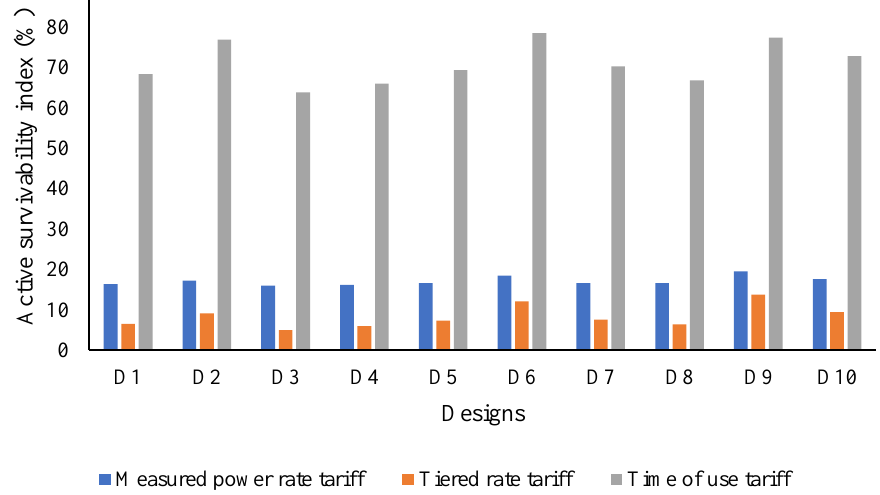
Figure 12. Active survivability indexes for the ten designs in the reference scenarios and three business models of dynamic pricing tariff.